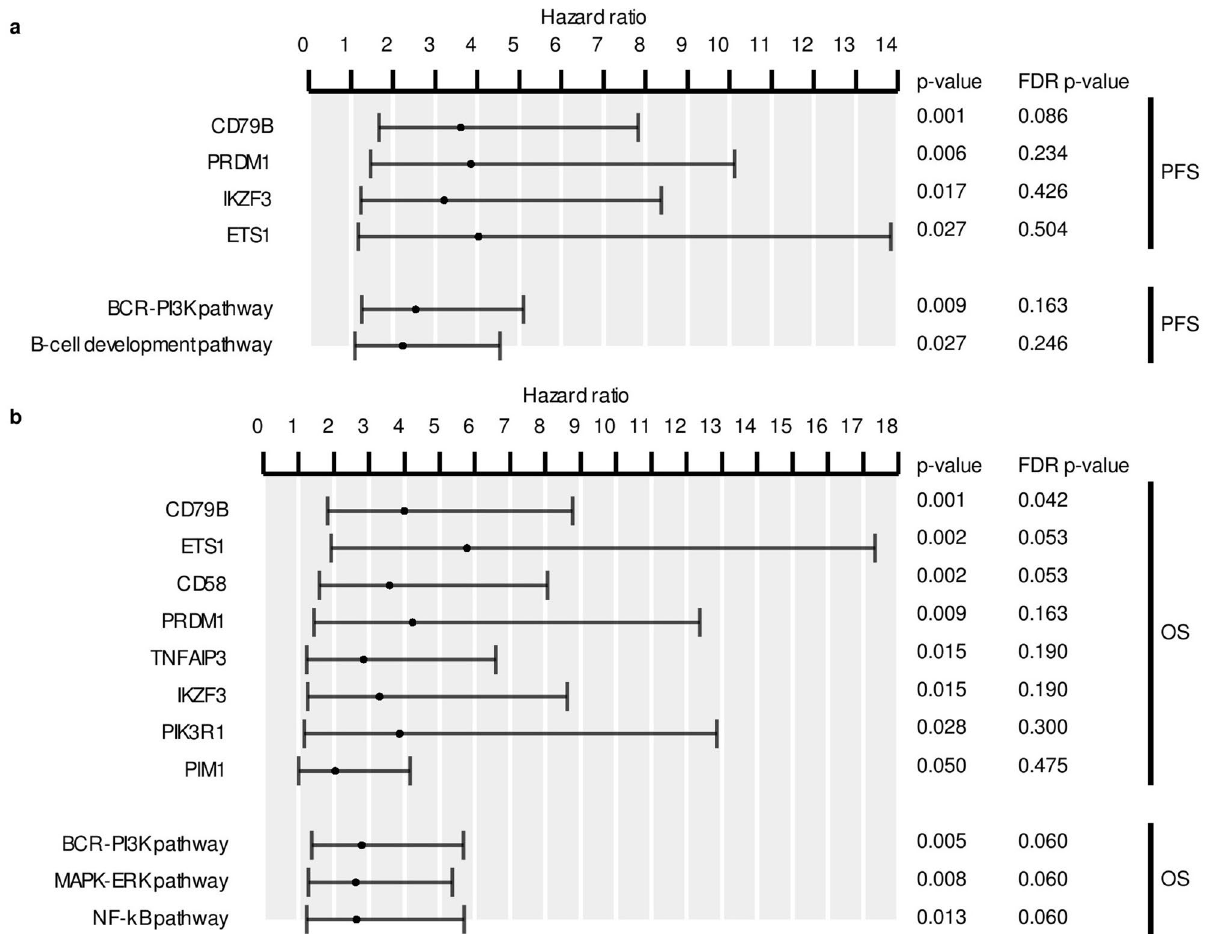
Figure 2. Statistical analysis of genes and pathways in the PdH cohort. Mutated genes and pathways with significant p-values in the univariate Cox proportional-hazards model analysis for ( A ) progression-free (PFS) and ( B ) overall survival (OS). Error bars represent the 95% confidence intervals for the hazard ratios. FDR p-values for Benjamini–Hochberg correction are